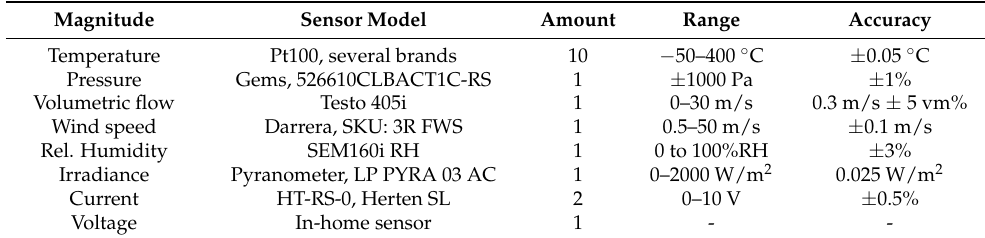
Table 2. Technical description of the main measurement instruments.